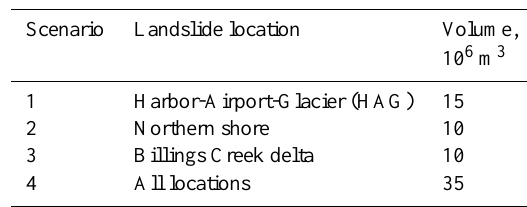
Fig. 1. Using seismic wavefront data, Christensen and